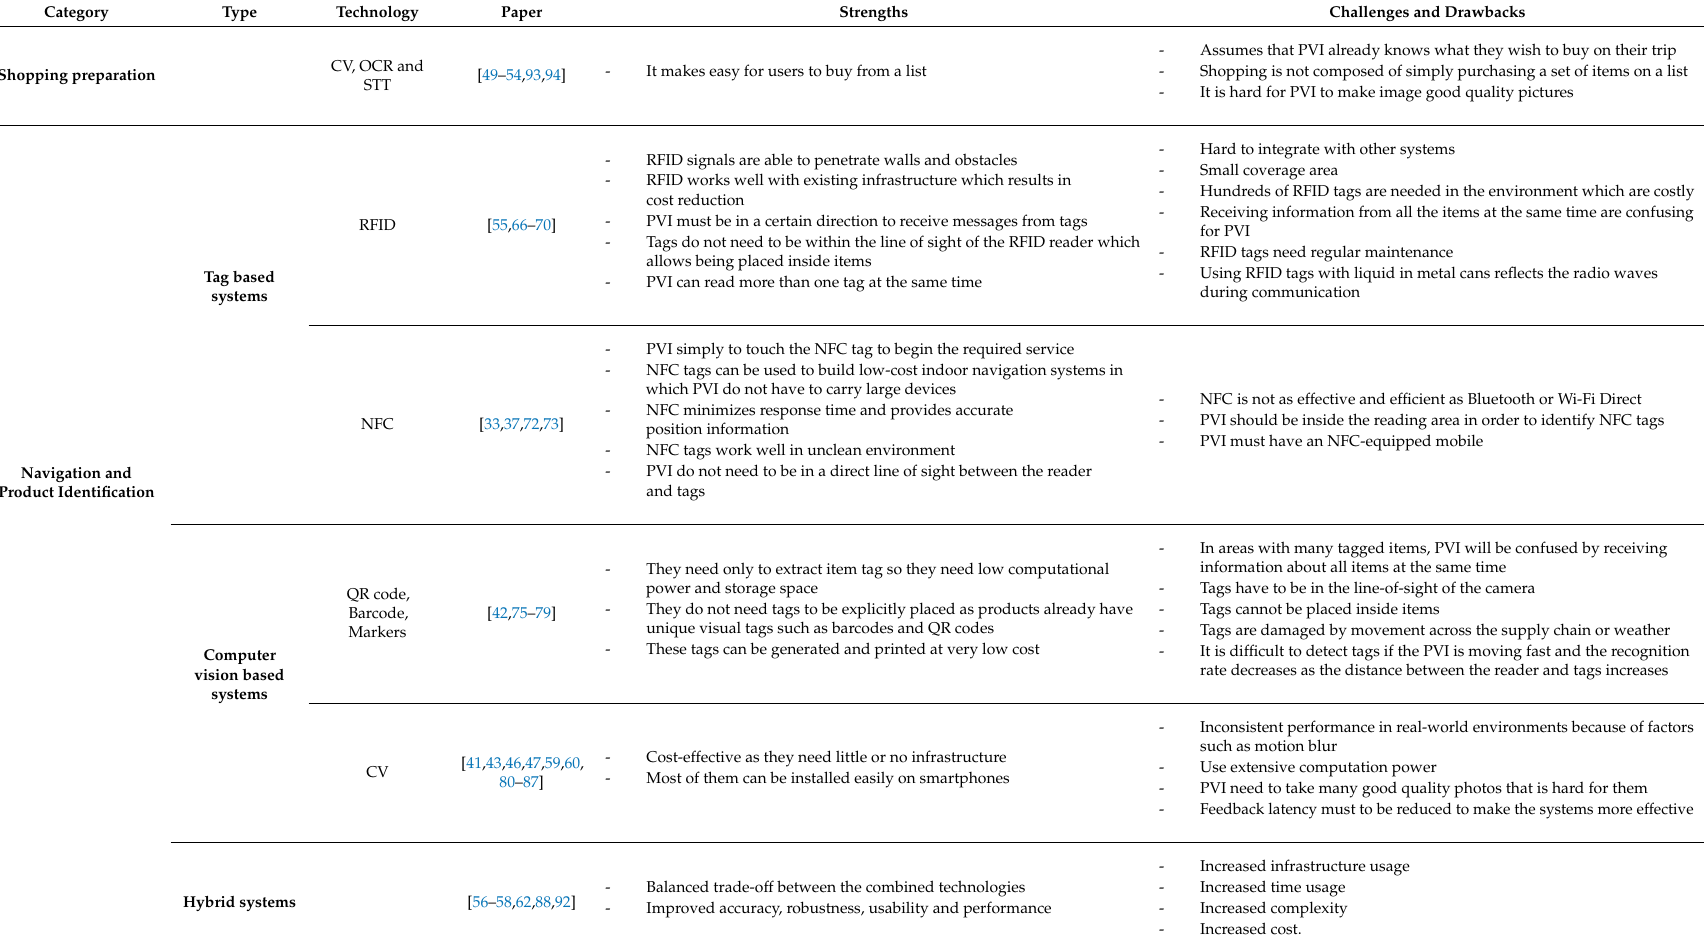
Table 1. Strengths, challenges and drawbacks of each